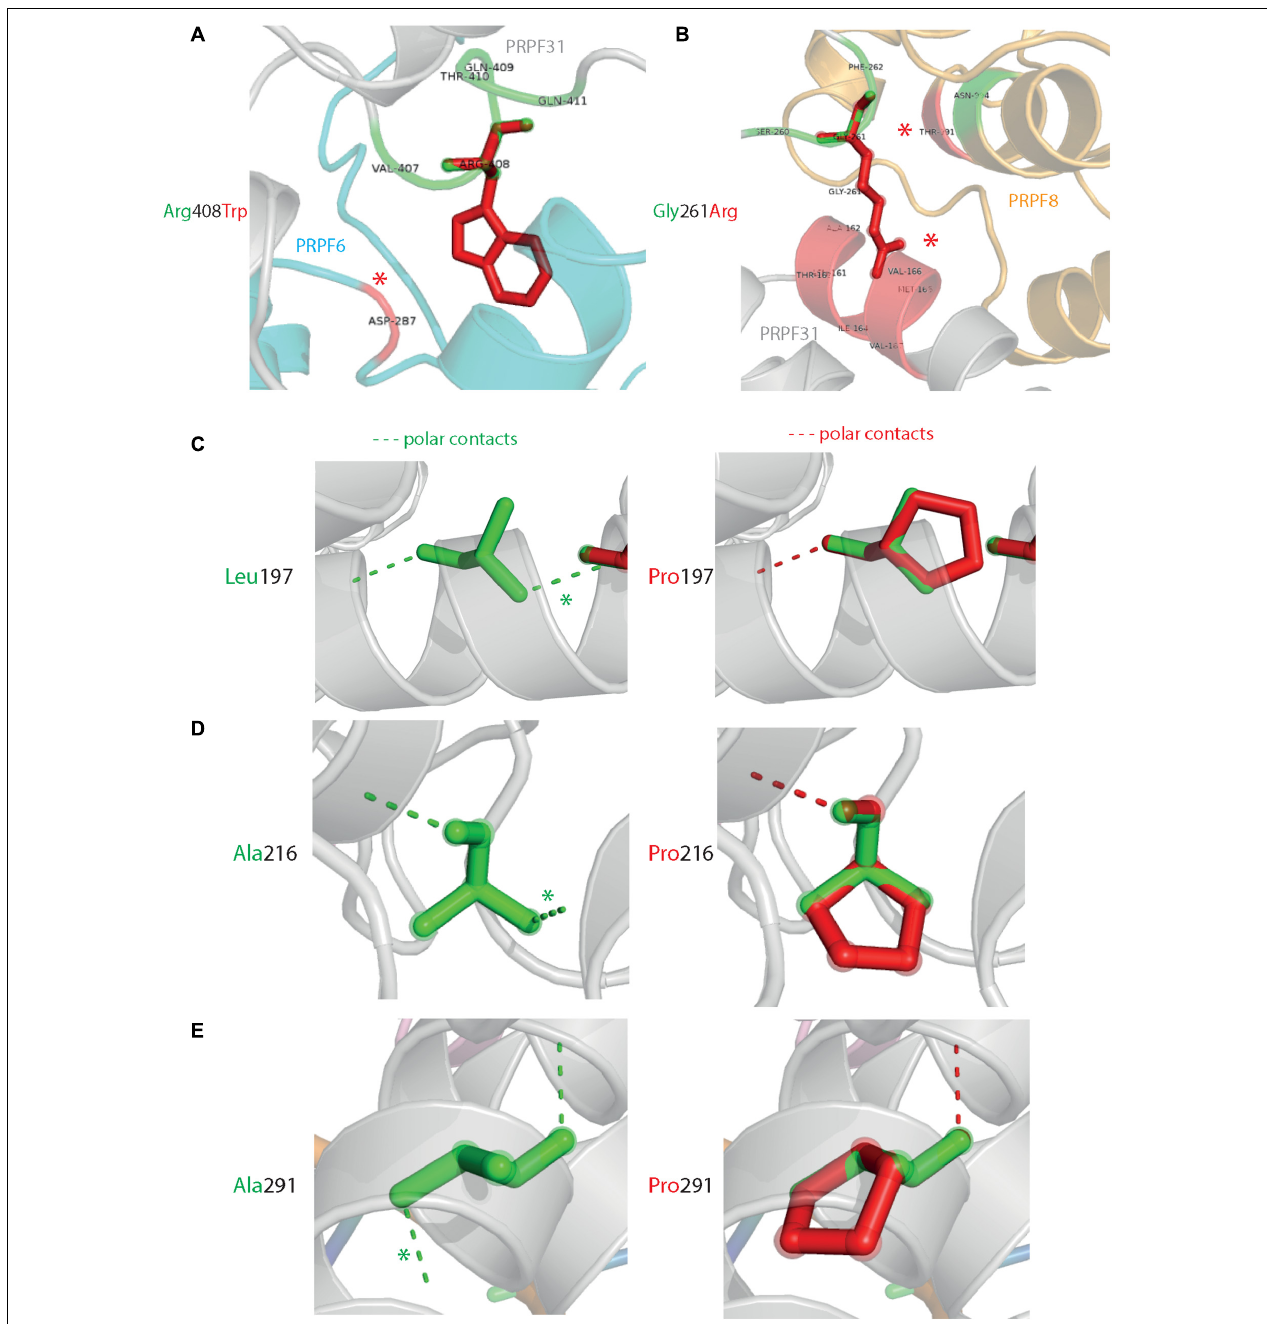
FIGURE 4 | 3D cartoon representation of regions of PRPF31 with published missense mutations and their interactions with other molecules within 4 Å, and their polar contacts. Cartoon representation of alpha helical structure of regions of PRPF31 (gray), with published missense mutations (A) Arg408Trp showing how this affects interaction with PRPF6 (blue) and (B) Gly261Arg showing how this affects interaction with PRPF8 (orange). Red asterisks are used to label where missense mutations introduce new H bonding. Cartoon representation of alpha helical structure of regions of PRPF31 (gray), with published missense mutations (C) Leu197, (D) Ala216Pro, and (E) Ala291Pro showing effect of these missense mutation on loss of polar contacts within PRPF31. Wild-type amino acid structure is shown in green, and mutant amino acid structure overlaid in red. Green asterisk shows polar contacts which are lost upon missense